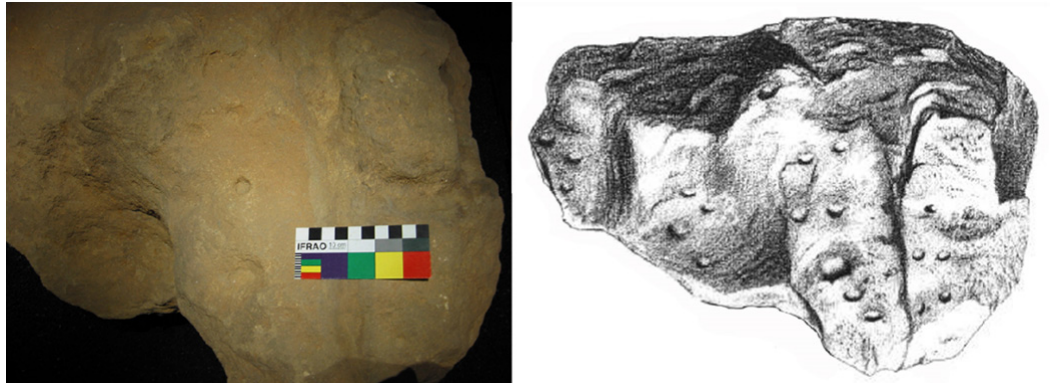
Figure 9. The sepulchral slab placed over “Neanderthal” child’s grave in the Mousterian cemetery of La Ferrassie, Dordogne,